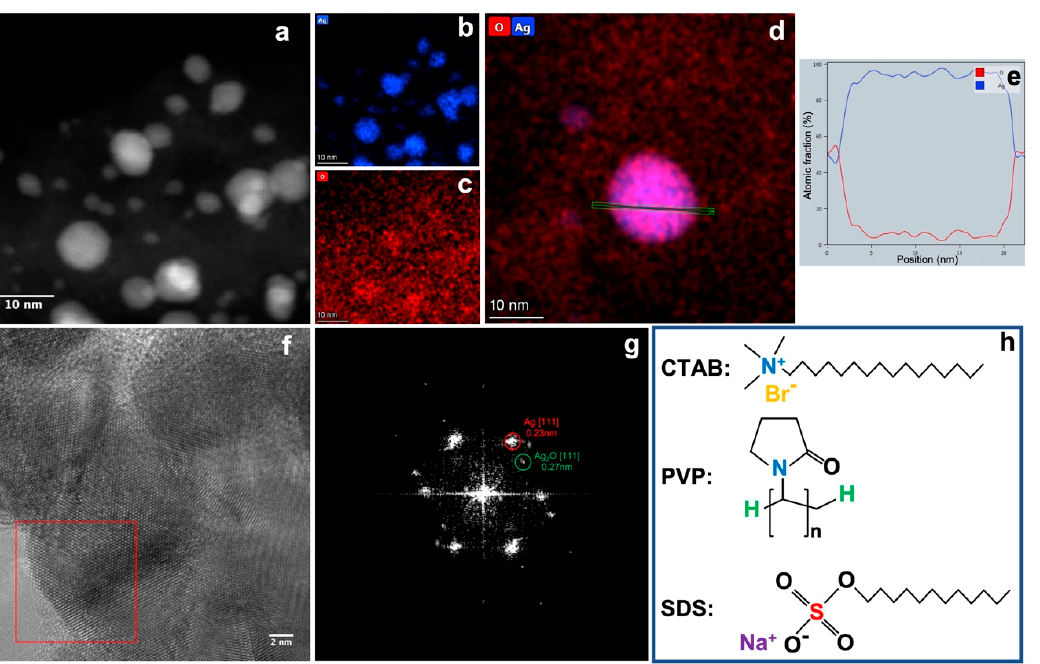
Figure 3. STEM image of Ag nanoparticles prepared with CTAB ( a ) and its EDS mappings of elements Ag ( b ) and O ( c ). EDS mapping of an individual Ag nanoparticle ( d ) shows the line profile ( e ) of the atomic fraction of Ag and O of the area marked in green in ( d ). HRTEM of Ag nanoparticles prepared with CTAB ( f ) and the FFT pattern of the nanoparticle boxed in red showing the presence of both Ag and Ag 2 O ( g , h ) illustrates the chemical structures of the three kinds of